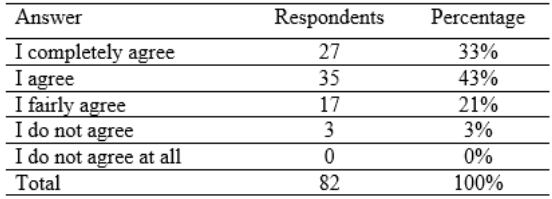
Table 2. Table of obtained answer to question number 3